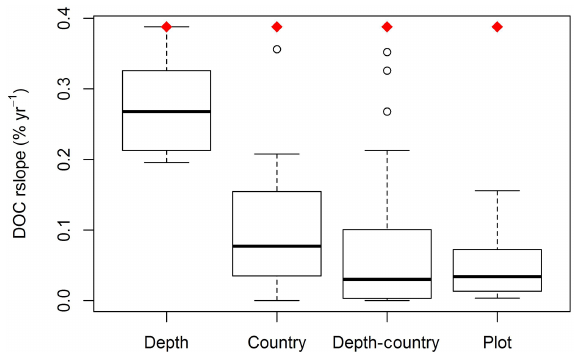
Figure 5. Range of relative trend slopes (max–min) for trends of DOC concentration in soil solution within each (1) depth interval, (2) country, (3) depth interval per country, and (4) plot. The box plots show the median, 25 and 75% quantiles (box), minimum and 1.5 times the interquartile range (whiskers) and higher values (cir- cles). The red diamond marks the maximum range of slopes in soil solution DOC trends in the entire dataset.